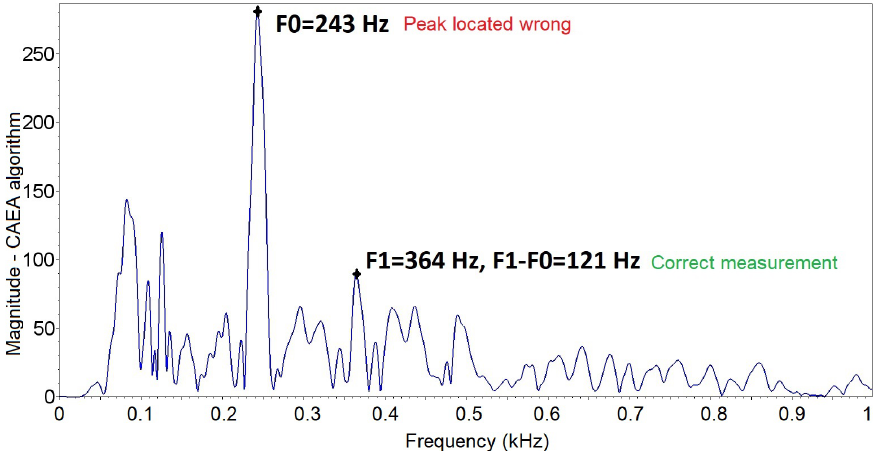
Figure 20. Frequency spectrum obtained by the CAEA algorithm (FFT method) with peak location error referring to the fundamental frequency of A. fraterculus of the standard group.